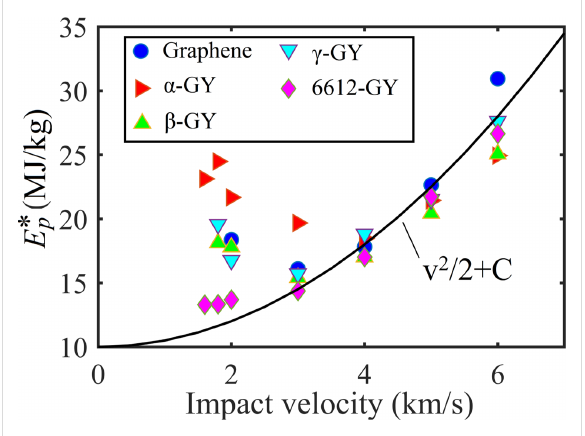
Figure 7: Specific penetration energy as a function of the impact velocity for GY and graphene